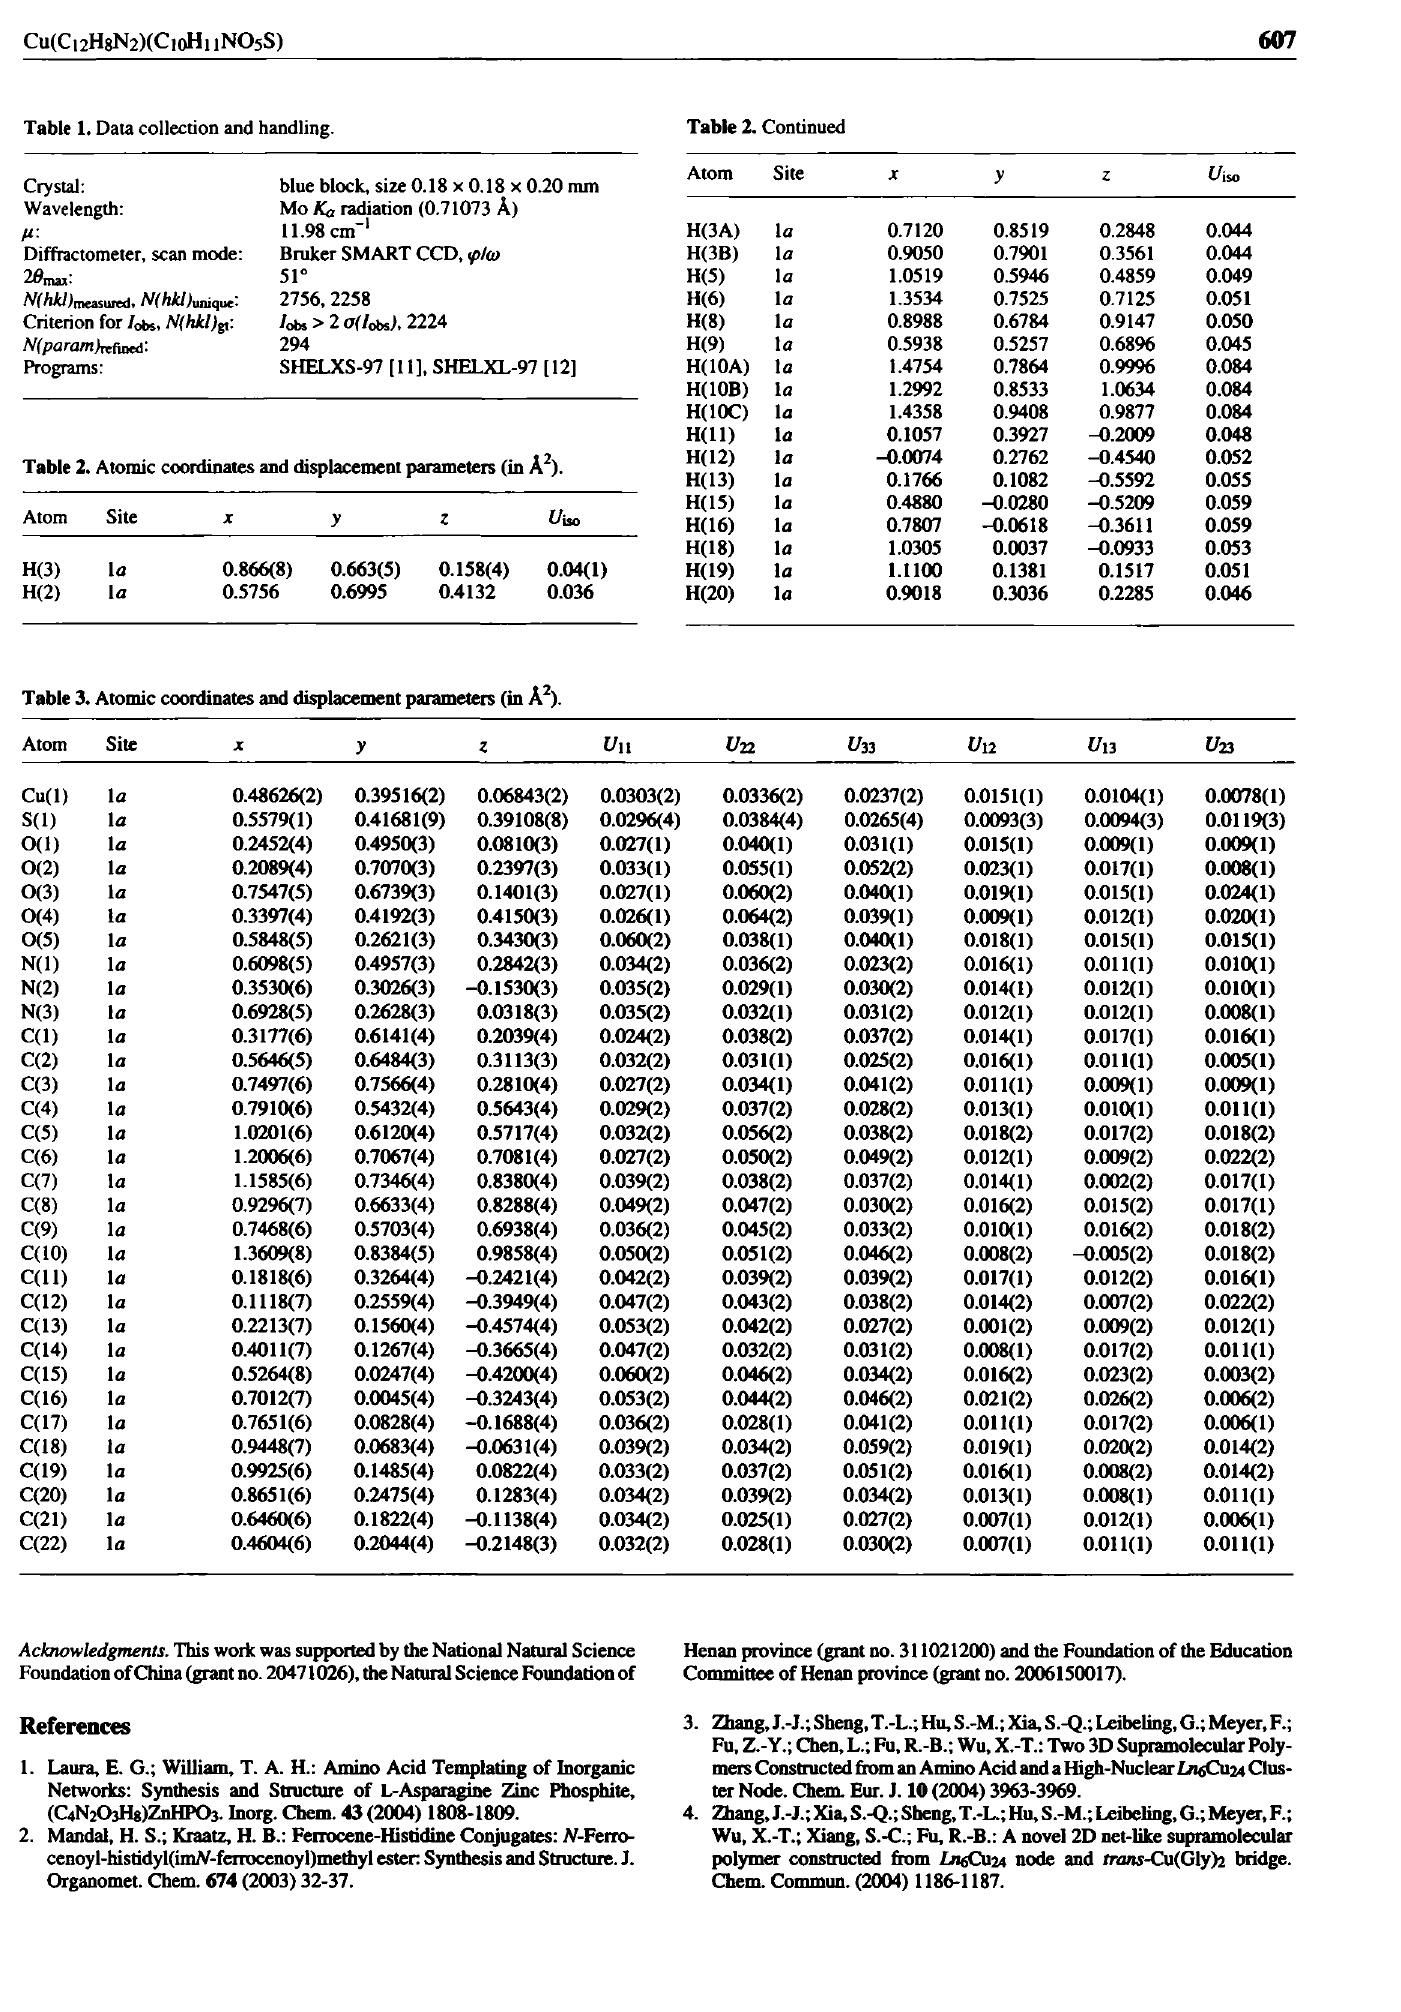
Table 2. Atomic coordinates and displacement parameters (in A 2 ).